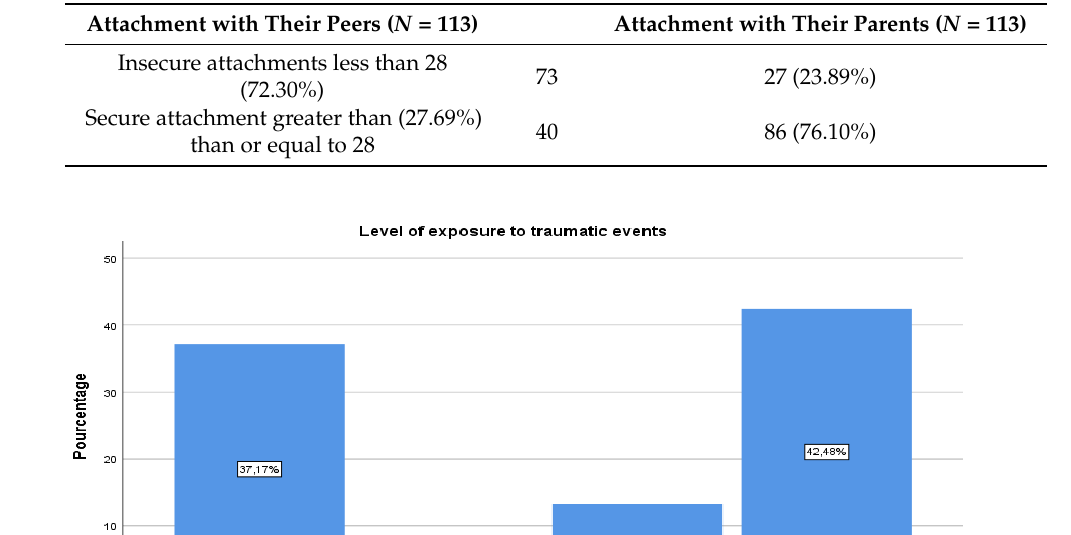
Table 1. Representations of children’s degree of attachment to their peers and parents.